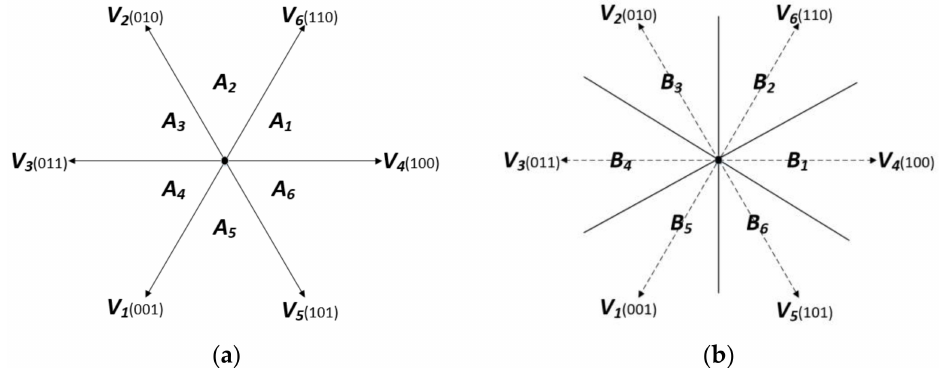
Figure 2. Two types of voltage sectors division: ( a ) conventional SVPWM; ( b ) TSPWM.